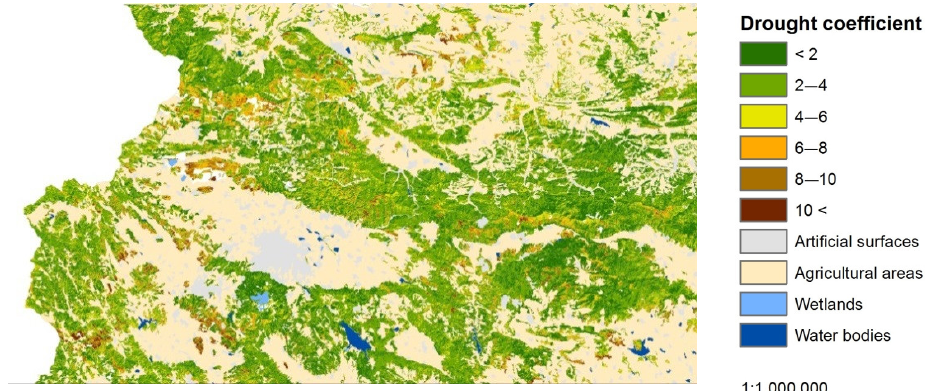
Figure 9. Distribution of the Drought coefficient (DC) at the end of August/beginning of Septem- ber 2019.